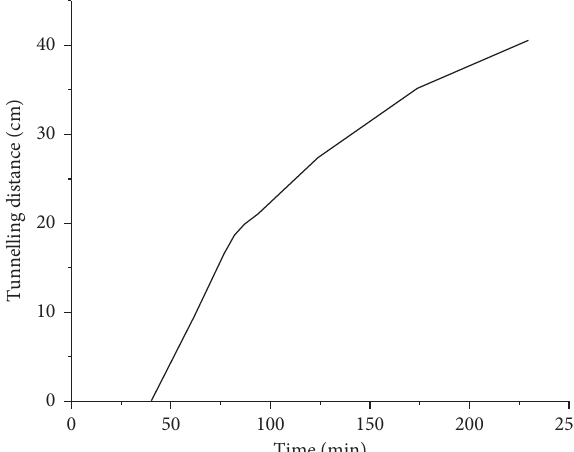
Figure 13: The relationship between shield tunnelling distance and test time.